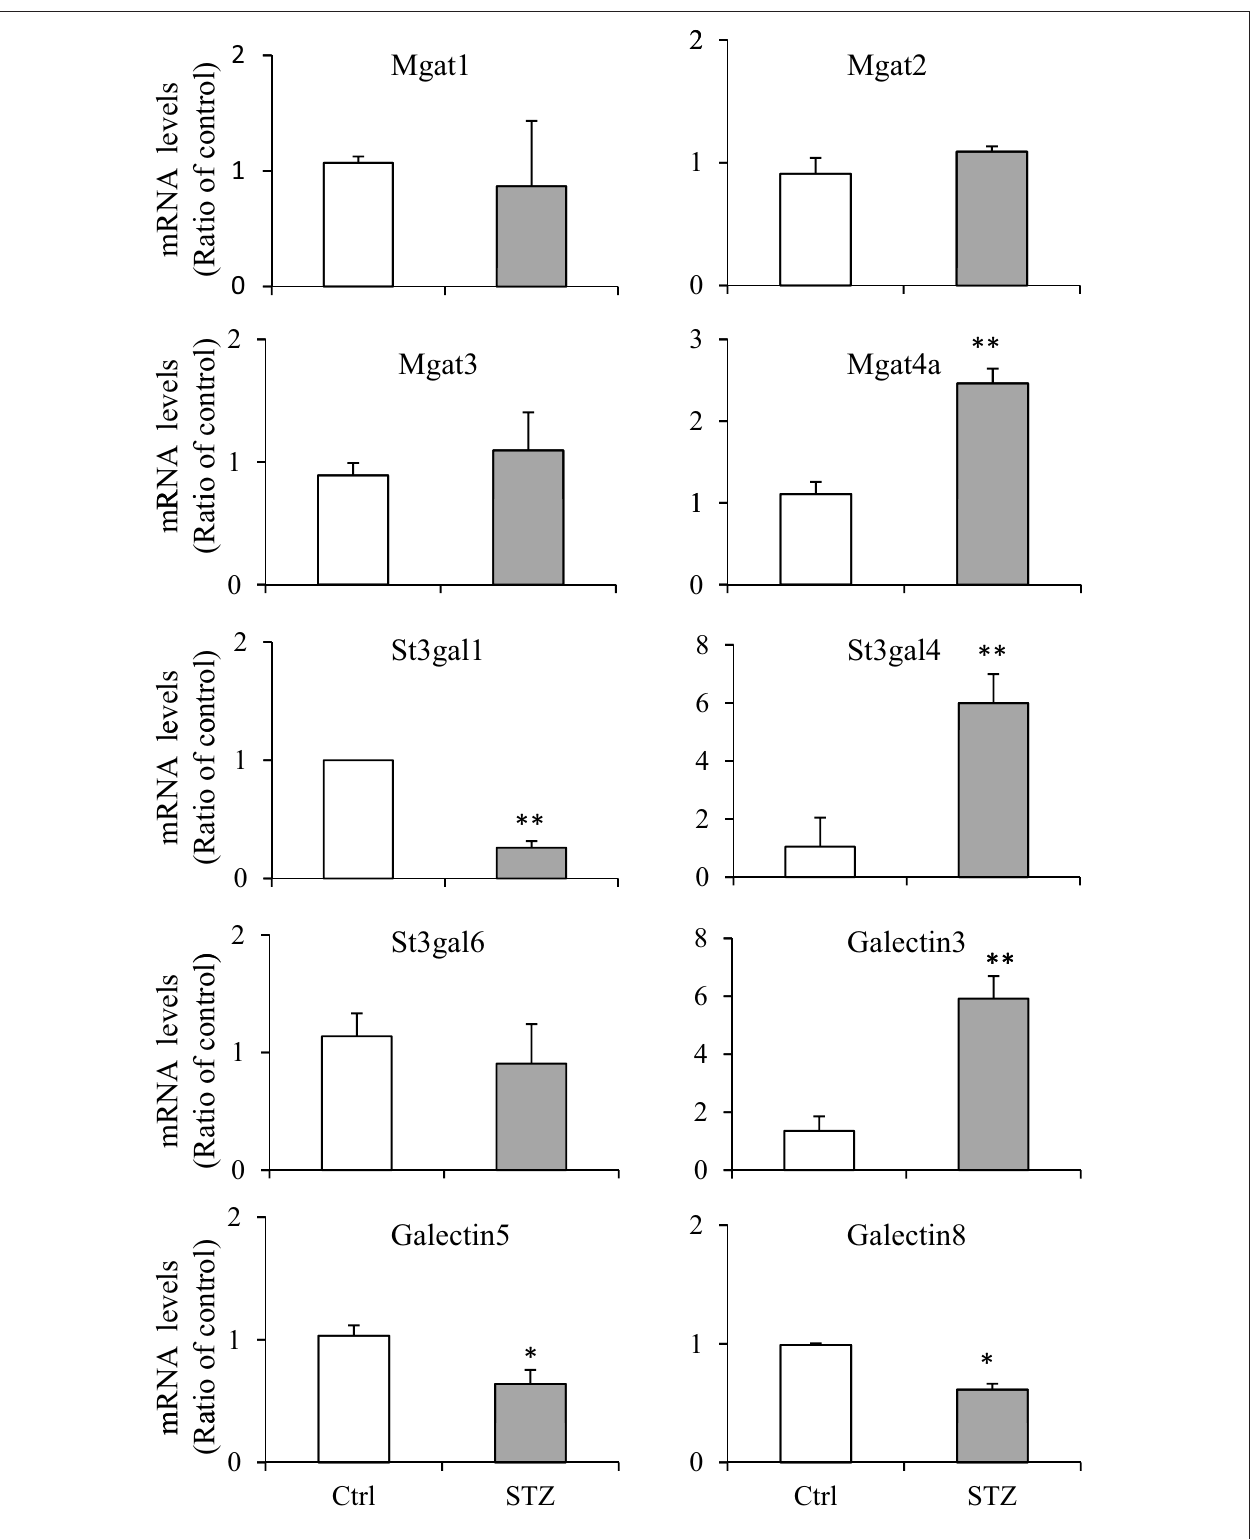
FIGURE 3 | Quantitative real-time PCR assays. RNAs were prepared from IM tip ( n = 3 /group) and subjected to quantitative PCR (qPCR) assays using the fluorescent dye SYBR Green. The target gene mRNA levels were normalized to GAPDH. Relative mRNA levels of the target gene in STZ rats were compared to the control rats, where the expression was set to 1.0 ( n = 3 ; values represent mean ± SD). A paired Student’s t -test was used to assess statistically significant differences (compared to control * P < 0.05 ; ** P < 0.01 ; NS, no significance).